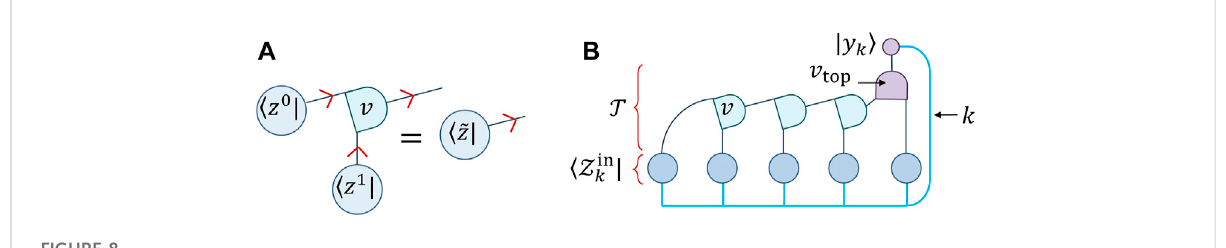
FIGURE 8 (A) Tensor v is a number-state preserving tensor mapping from two indices to a single index. (B) An MPS network T is built from tensors v that preserve number-states when mapping from left-to-right. The MPS is trained as a classi fi er by maximizing the scalar product (cid:17) k 〈 Z in k | T | y k 〉